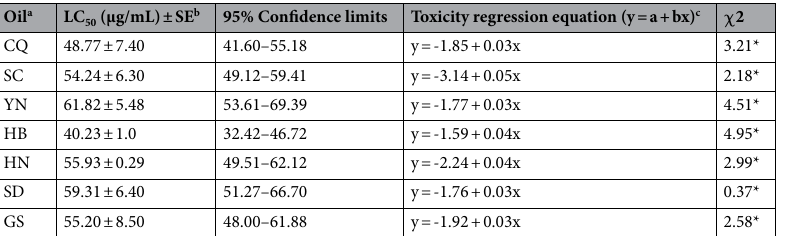
Table 1. Larvicidal activity of essential oils distilled from seven geographical regions of mugwort leaves in China against the 4th instar larvae of An. sinensis . a CQ, SC, YN, HB, HN, SD and GS: essential oils from Chongqing, Sichuan, Yunnan, Hubei, Henan, Shandong and Gansu province/municipality, respectively. b Determined by log-probit analysis with at least 6 concentrations, and three repetitions “SE” denote standard error. c y stands for the probability transformation value of percent mortality of mosquitoes, and x for the concentration of essential oil, respectively. *Significant at p <